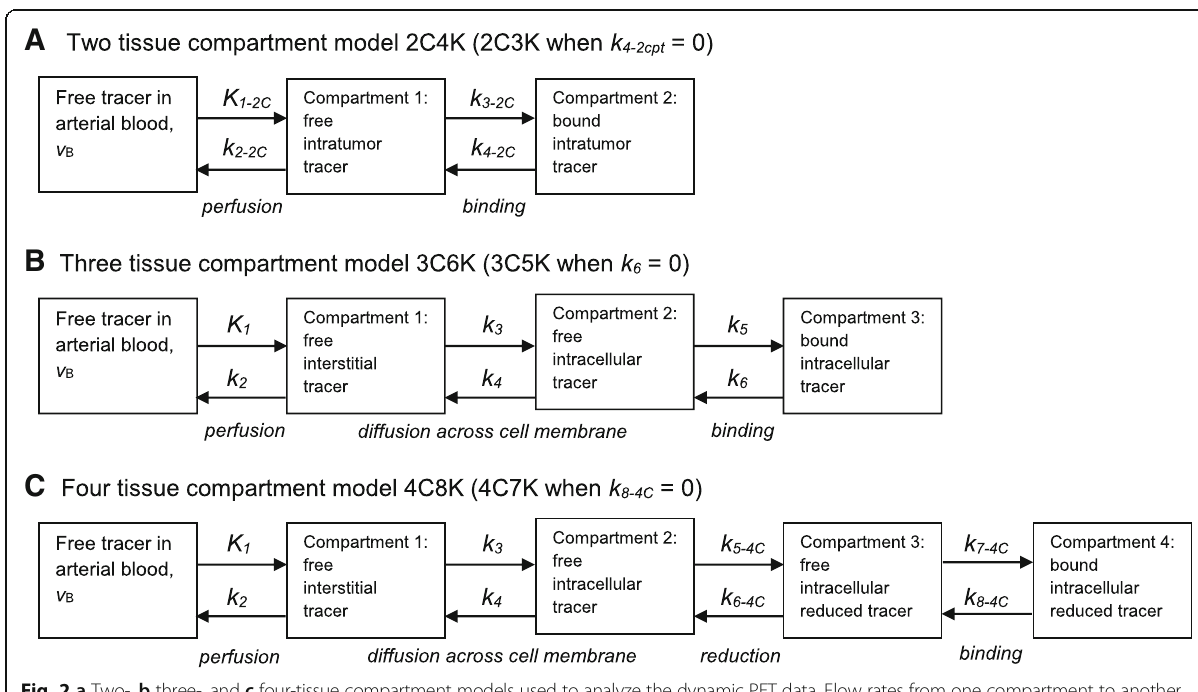
Fig. 2 a Two-, b three-, and c four-tissue compartment models used to analyze the dynamic PET data. Flow rates from one compartment to another are defined by rate-constants ( k values), tracer concentrations and compartment volumes [12] . The fraction of the tumor volume occupied by blood is denoted in each model as ν